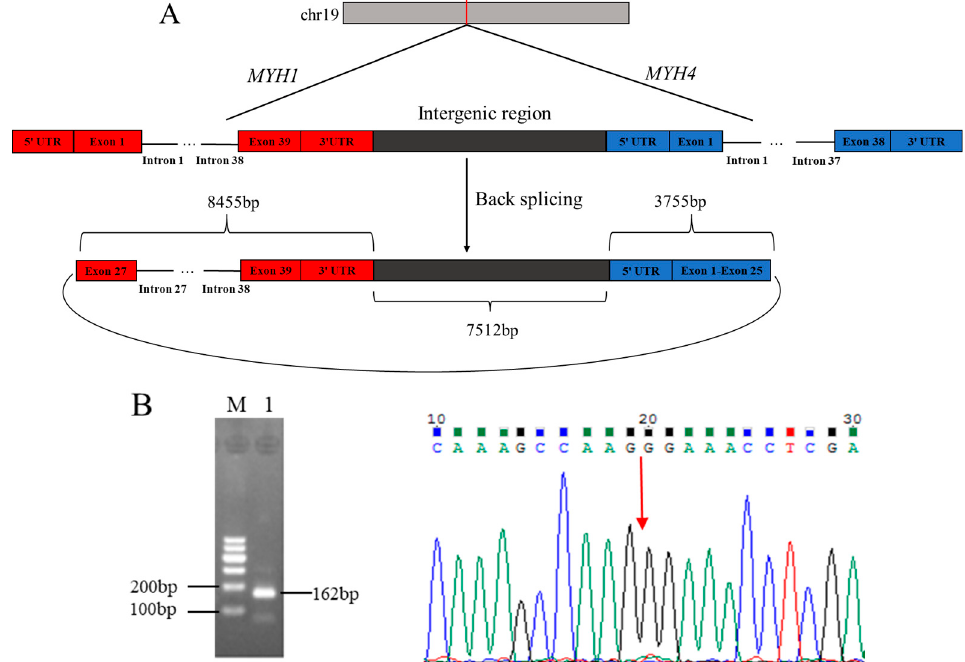
Figure 1. The structure of caprine circ_003628 derived from MYH1 and MYH4 ( A ) and validation of the authenticity of the circRNA using RT-PCR and Sanger sequencing ( B ). M: Marker; 1: circ_003628. The head-to-tail splice junction site for circ_003628 is marked with a red arrow.